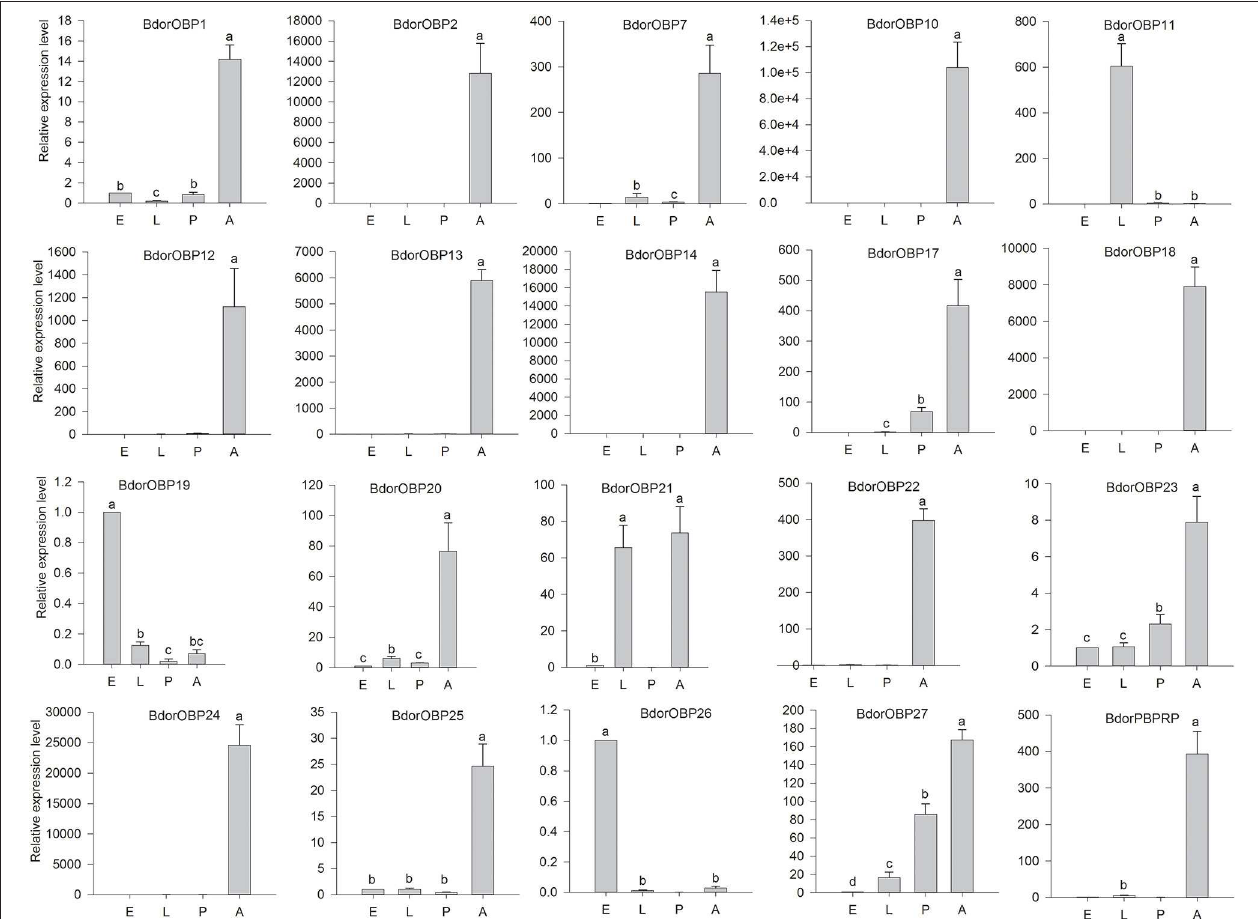
FIGURE 4 | Expression profile of B. dorsalis OBPs in different developmental stages. Total RNA was extracted from eggs (E), larvae (L), pupae (P), and adults (A). The black rectangles show the expression level of the OBPs in different developmental stages. The bars represent mean ± SD, and the letters indicate statistically significant differences between the groups (Tukey’s honest significant difference